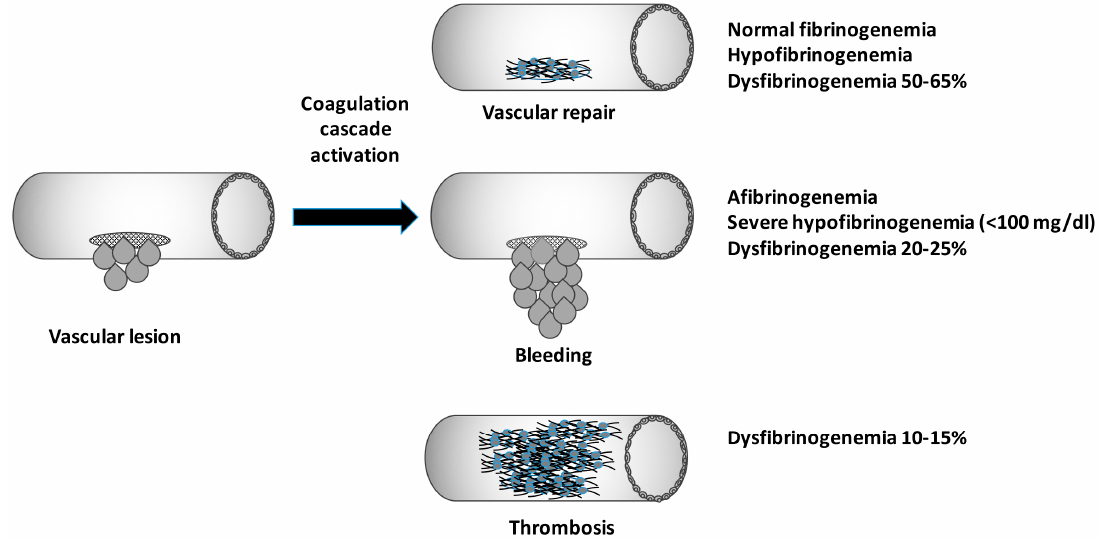
Figure 2. Graphic schematic representation of possible clinical phenotype following a genetic impairment of the fibrinogen molecule.